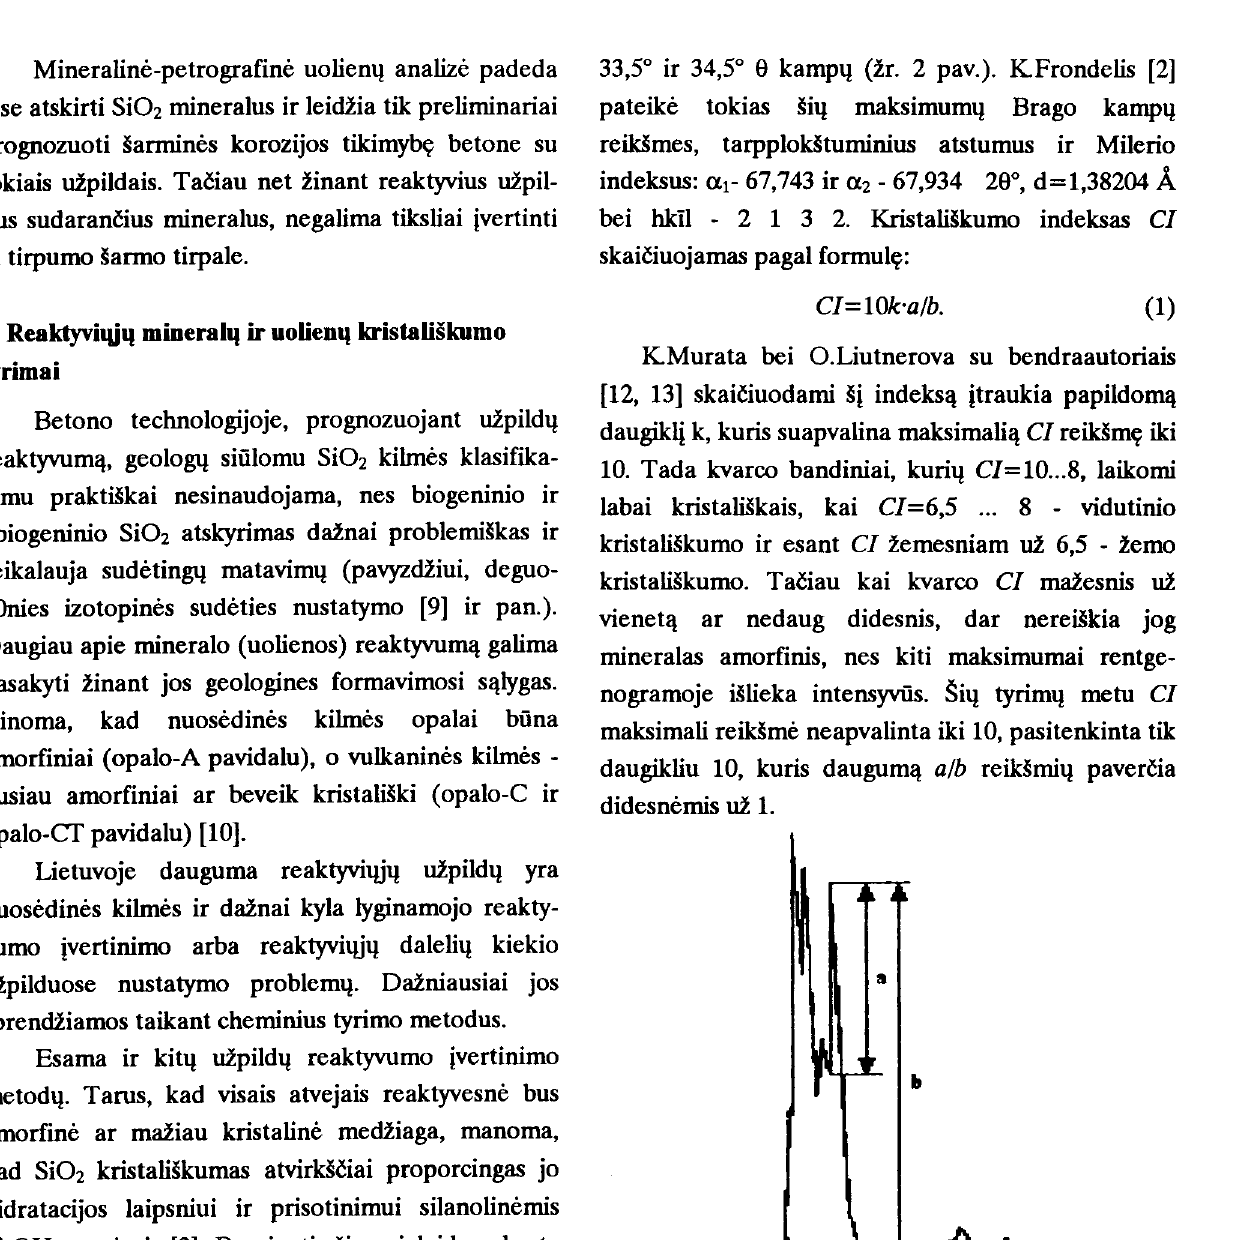
Fig. 2. Estimation of quartz crystallization according relative height CI=lOa/b of maximum d= 1,38204A duplicate a1,